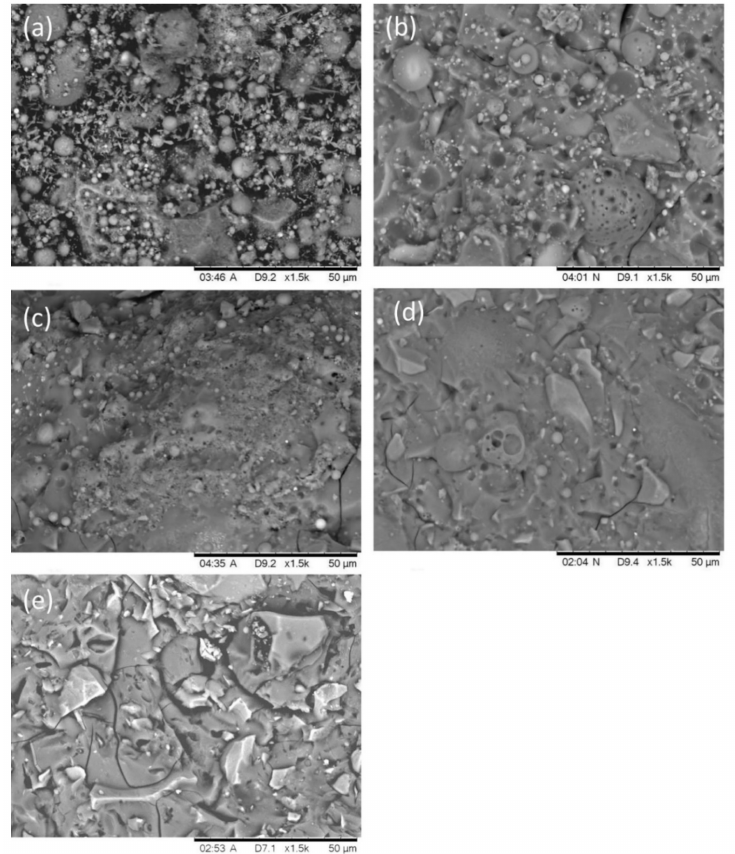
Figure 12. The microstructure of the AAFS with the slag content of 0 ( a ), 30% ( b ), 50% ( c ), 70% ( d ), and 100% ( e ) at 7 days (the activator modulus is